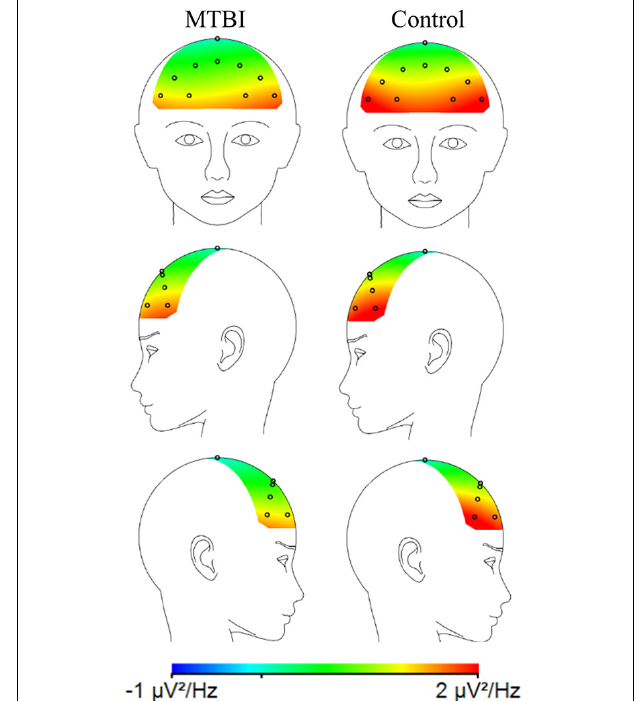
FIGURE 2 | A topographic plot illustrating the average alpha power ( µ V 2 /Hz) for the MTBI group (on the left) and the Control group (on the right) in the frontal electrodes. The MTBI group had relatively more negative FAA (lnF4-lnF3) than the Control group, i.e., relatively less alpha power on the right (F4) than left frontal (F3) electrodes. This is thought to indicate greater cortical activity on the right compared to the left frontal